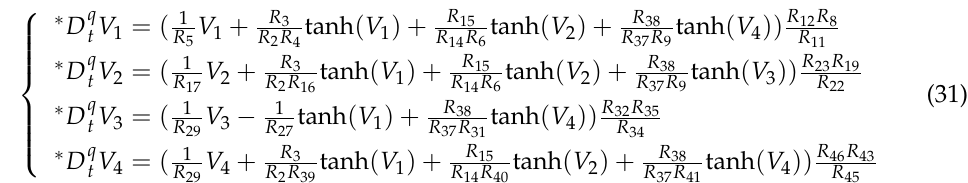
Table 2. Values corresponding to the components. Components